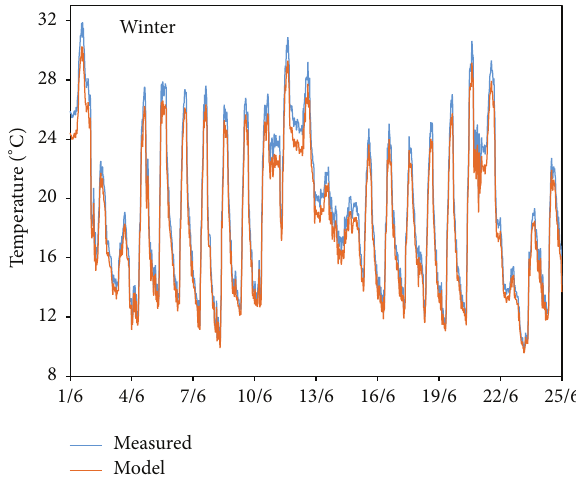
Figure 12: Winter comparison of the measured and the modeled temperatures.